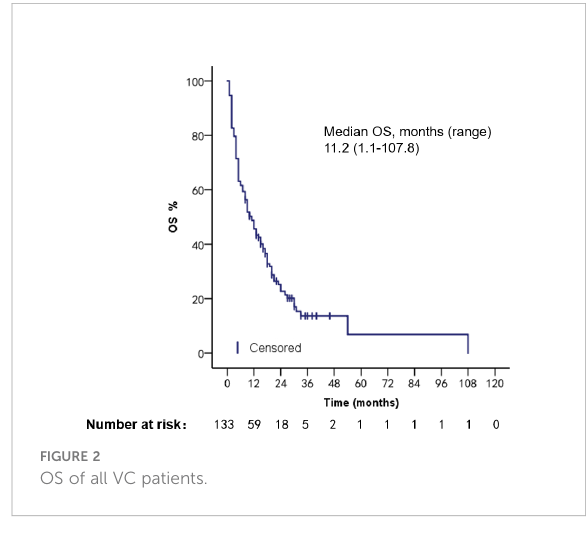
FIGURE 1 PFS of all VC patients.